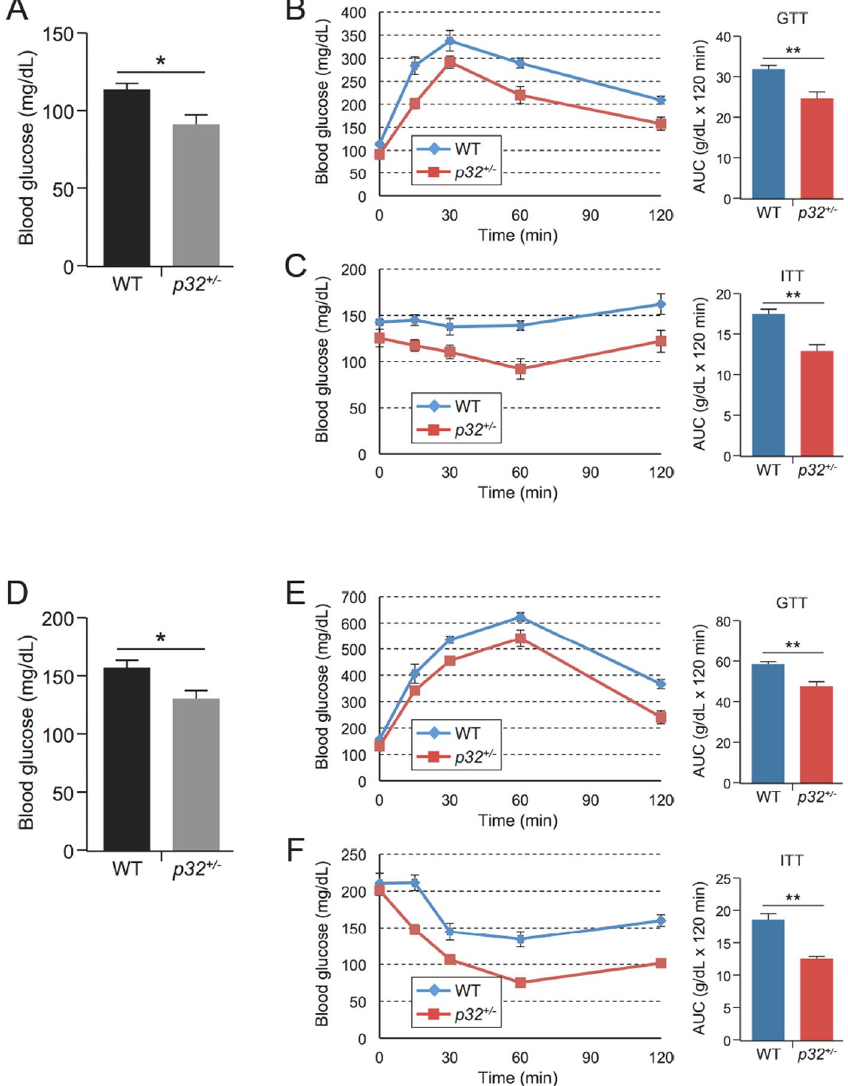
Figure 3. p32 heterozygosity increases glucose tolerance and insulin sensitivity. ( A ) Average fasting blood glucose levels of 52-week-old mice fed NC (n = 6). ( B ) Glucose tolerance test (GTT) and ( C ) insulin tolerance test (ITT) in 52-week-old mice fed NC (n = 6). Bar graphs to the right quantify the areas under the curves (AUC). ( D ) Average fasting blood glucose levels in mice fed an HFD for 10 weeks (WT, n = 7; p32 + / − , n = 5). GTT ( E ) and ITT ( F ) assays in mice fed an HFD for 10 weeks (n = 5). Bar graphs to the right quantify the areas under the curves